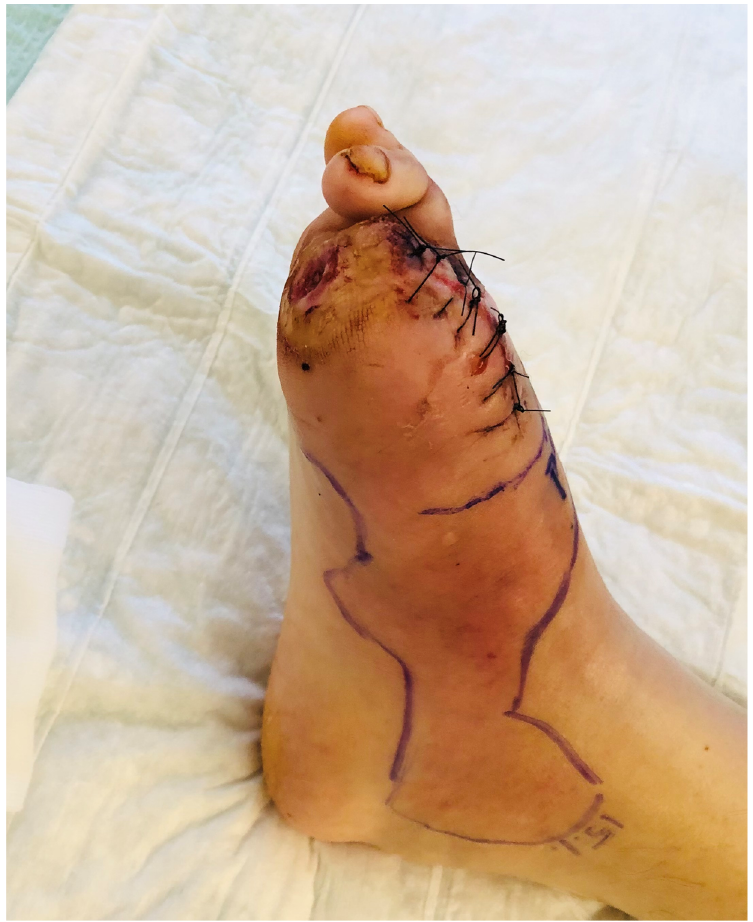
Figure 2. Amputation of the hallux (including the sesamoid bones) in a middle-aged woman for diabetic foot osteomyelitis developing in the setting of a long-standing, neglected plantar ulcer. The infection in the bone was chronic, but was recently complicated by an acute flare of soft tissue infection; this could be a spread from the underlying bone or a new infectious episode caused by a new pathogen. After discussion with the patient, we decided to remove the ulcer along with the underlying infected bone; we debrided the soft tissues, but left the majority of the infected soft tissue, which was treated with systemic antibiotic therapy. In this photograph, taken the first postoperative day, note the substantial residual soft tissue infection, along with a small postoperative hematoma in the forefoot. (Photograph obtained with permission of the patient.).